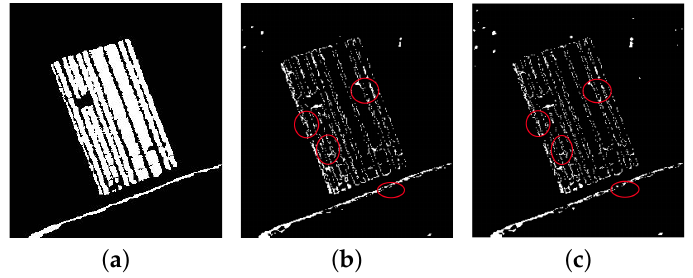
Figure 14. The false alarms of the change detection map on the Farmland D data set: ( a ) Reference. ( b ) The false alarms of change map that use gcForest. ( c ) The false alarms of the change map that use the proposed method. (The areas of the red circles are the places where the changes in the two figures are obvious.)